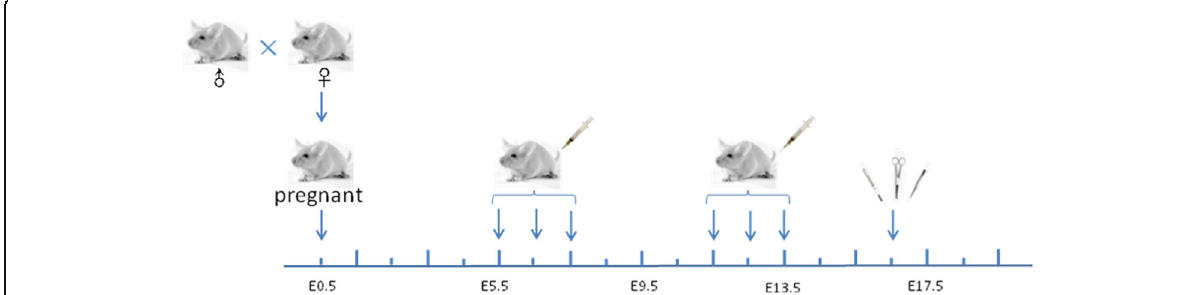
Fig. 1 Schematic illustration of A30 exposure and animal processing and sampling. CD-1® (ICR) mice were mated overnight and the presence of a vaginal plug on female mice was designated as embryonic day 0.5 (E0.5). For early pregnancy exposure, daily intravenous injection was started from E5.5 for 3 consecutive days, with the injection vehicle and dose as described in the Methods; for late pregnancy exposure, daily intravenous injections commenced on E11.5 and continued for 2 more days. Various test samples from maternal and fetal tissues were collected at